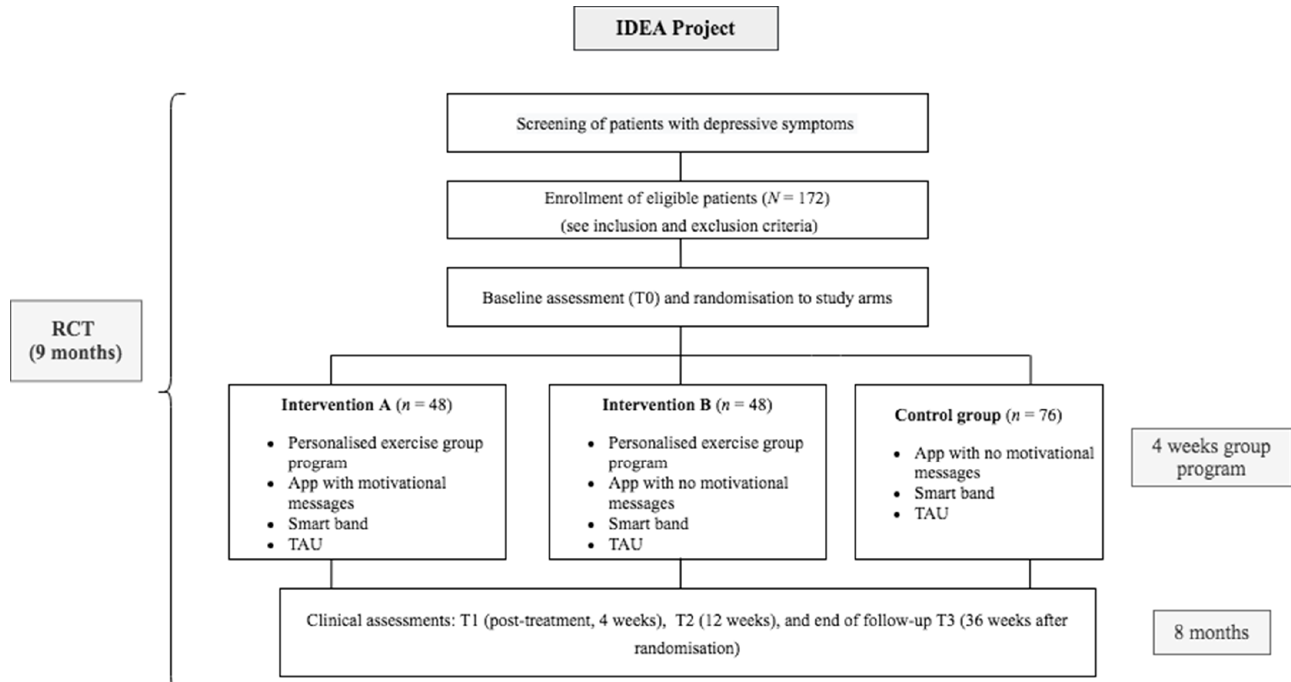
Figure 1. Flowchart of the IDEA Project. IDEA: Improving Depression through Exercise and Activity; RCT: randomised controlled trial; TAU = treatment as usual; T1 = 4-week assessment; T2 = 12-week assessment; T3 = 36-week final assessment.